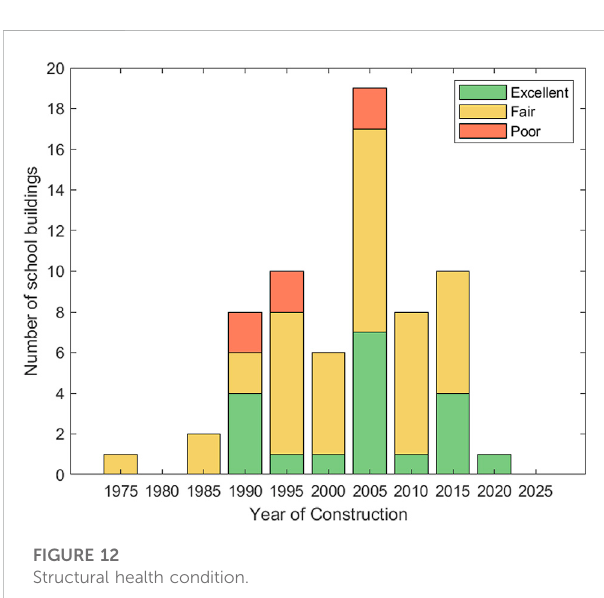
FIGURE 12 Structural health